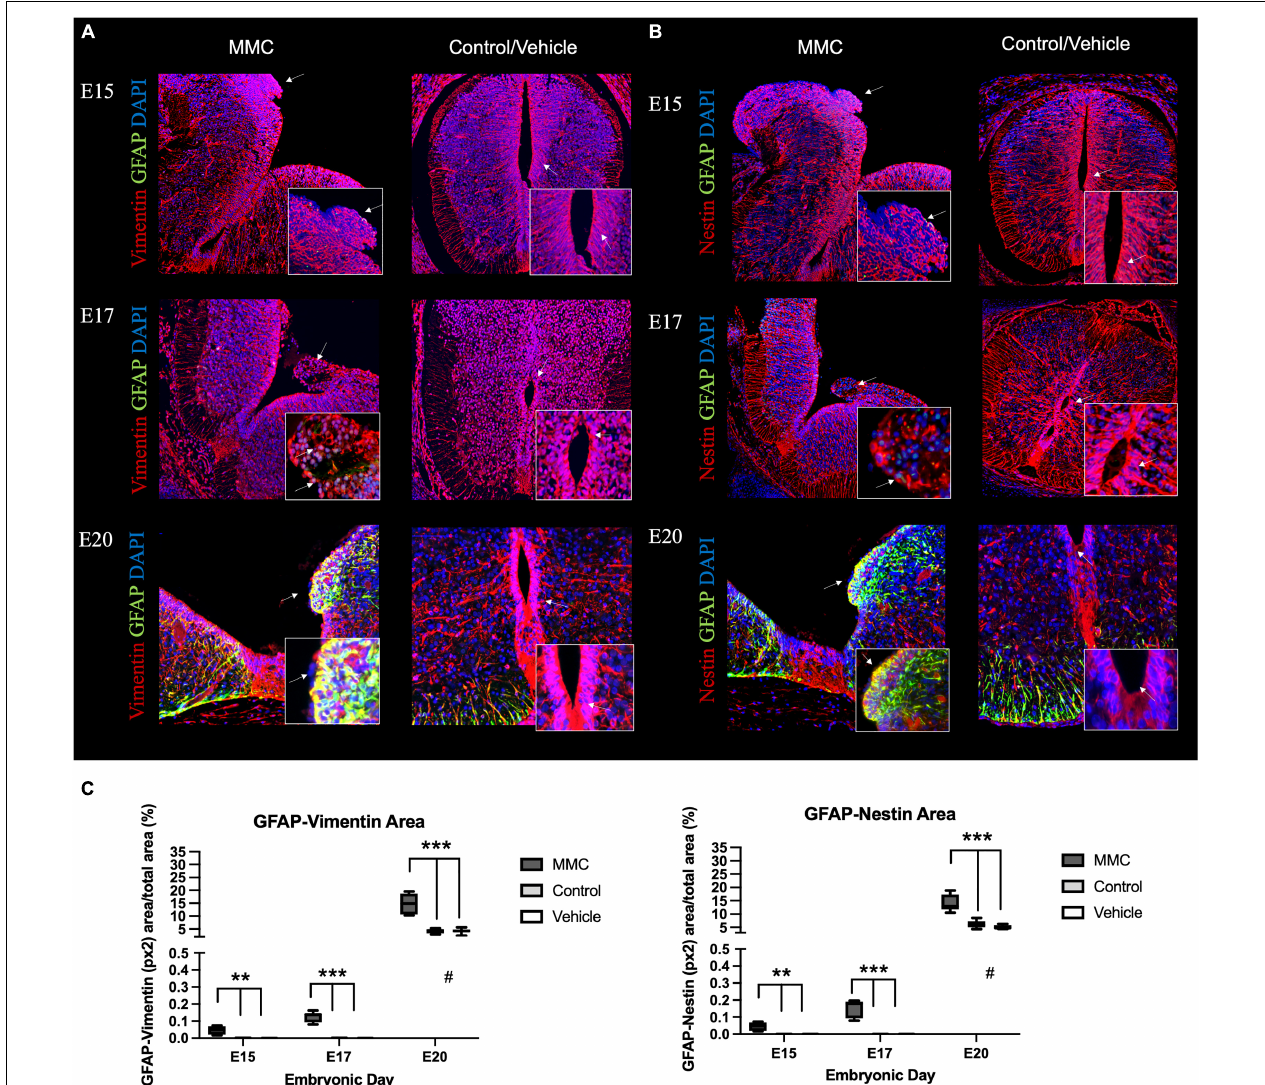
FIGURE 2 | In utero progressive astrogliosis in spina bifida. Progressive early astrogliosis in spina bifida (MMC) at E15, E17, and E20 compared with control spinal cords. Progressive GFAP (green) immunoreactive astrocyte cells, (A) vimentin (red) and (B) nestin (red) reactive astrocytes co-localization (yellow) and DAPI (blue) at E15, E17, and E20 in spina bifida (arrows) (20 × ). Control/Vehicle immunoreactive GFAP (green) astrocytes in white matter beneath the pial surface at E20 in normal spinal cords (20 × ). Astrocytes GFAP (green) co-localized with (A) vimentin (red) and (B) nestin (red) in spina bifida fetuses at in the VZ region compared with controls/vehicle with no expression of GFAP in the VZ nor central canal (arrow). (C) GFAP + Nestin and GFAP + Vimentin-stained area/total picture area in all groups at three gestational ages E15, E17, and E20 (means ± SD, ** p < 0.01, *** p < 0.001, # p < 0.05 between control and vehicle groups at E20 compared to E15 and E17).